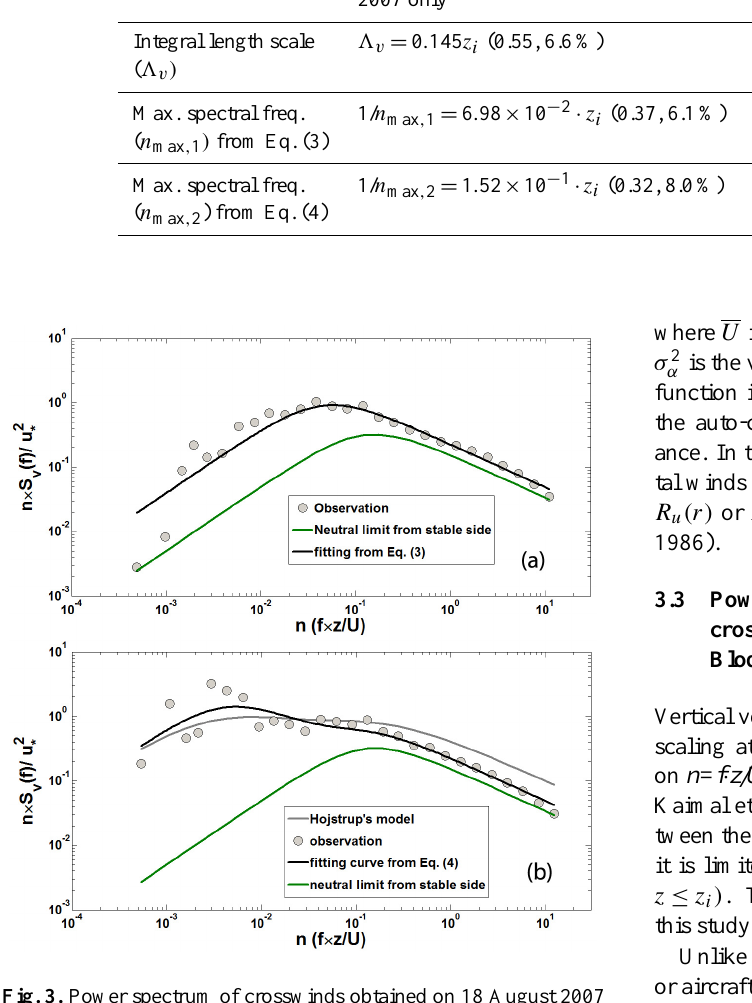
Fig. 3. Power spectrum of crosswinds obtained on 18 August 2007 for (a) slightly unstable air (07:30 ∼ 09:00; − z/L =0.038) and (b) CBL (12:00 ∼ 13:30; − z/L =0.094). Gray circles denote observa- tion points, black solid lines represent fitting curves obtained from Eqs. (3) and (4), green lines describe the spectrum for neutral limit from stable side with A 0 = 0 . 8 and n max =0.16, and gray solid line shows the result of Hojstrup’s model with L=-70.1 and Z i